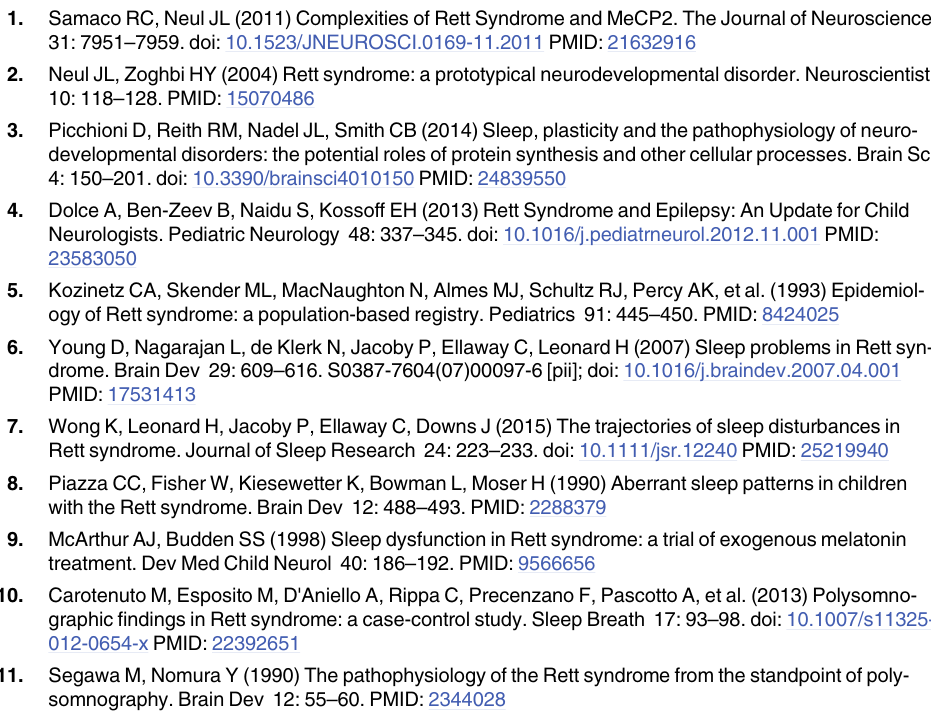
S1 Table. PSG sleep score data for age-matched control